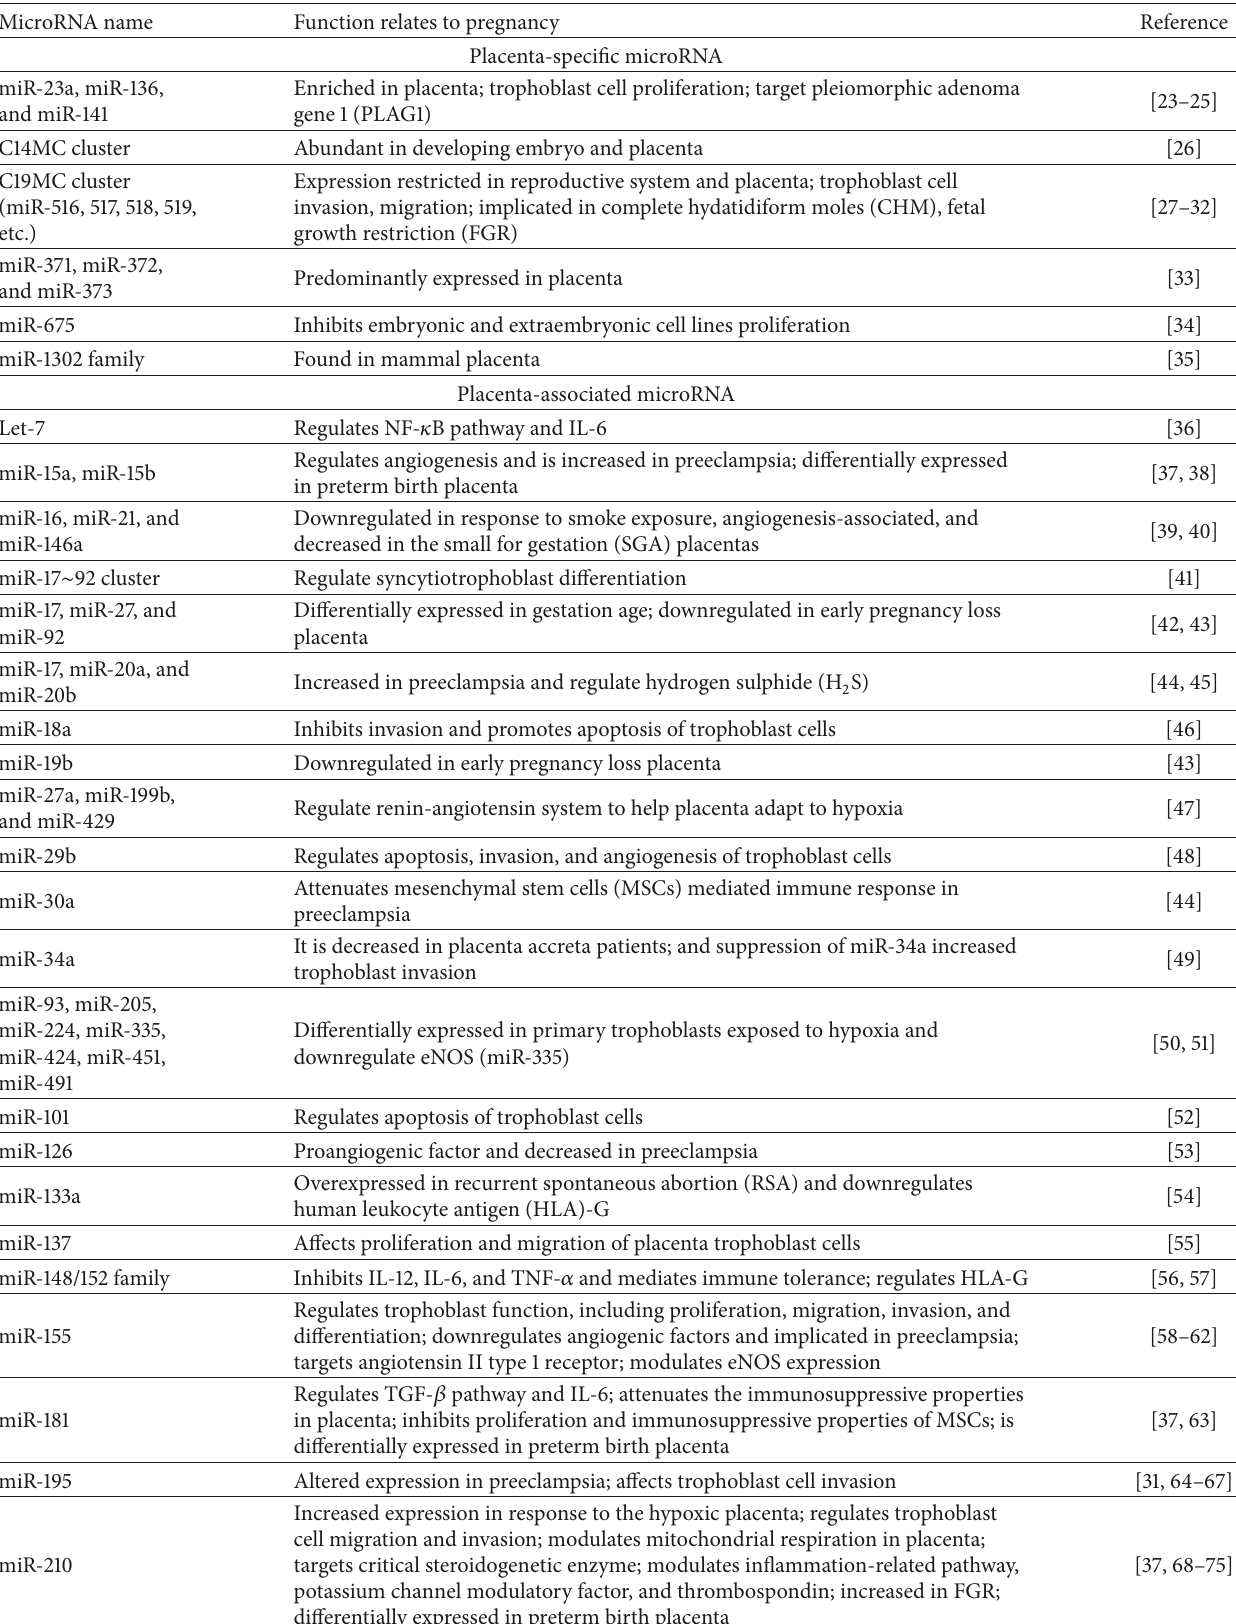
Table 1: A brief list of pregnancy-related